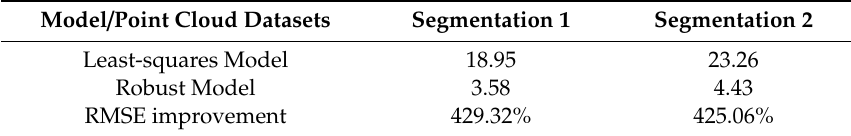
Table 2. The comparison of robust and least-squares